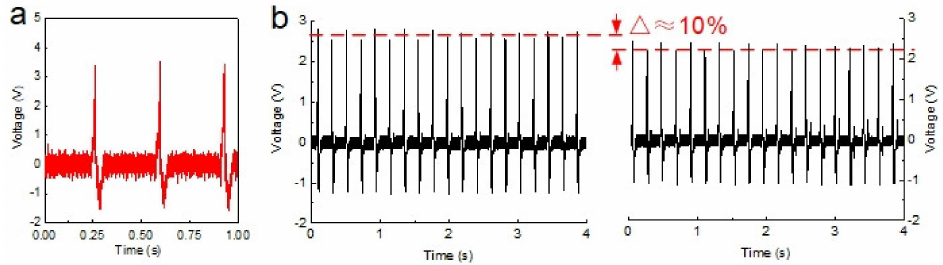
Figure 6. Piezoelectric characterization: ( a ) electromechanical response and ( b ) durability perfor- mance of self-powered